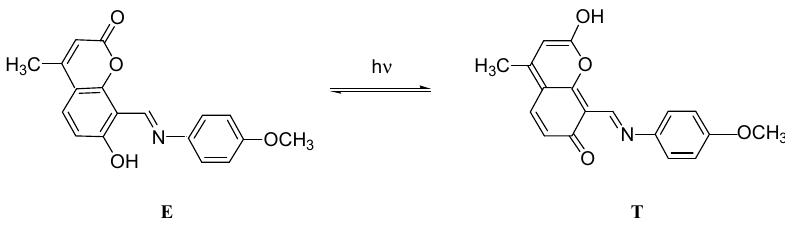
Scheme 10. Formation of the tautomeric form T of compound 3